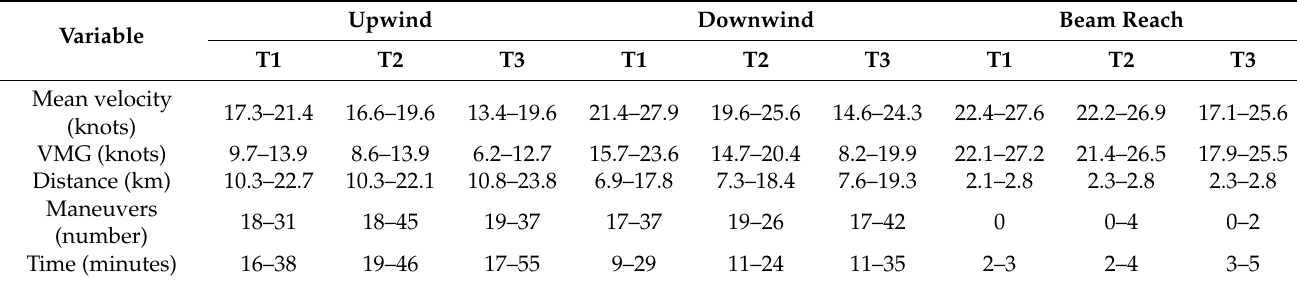
Table 3. Maximum and minimum values of the analyzed variables of sailors with different performance levels. Upwind Downwind Beam Variable